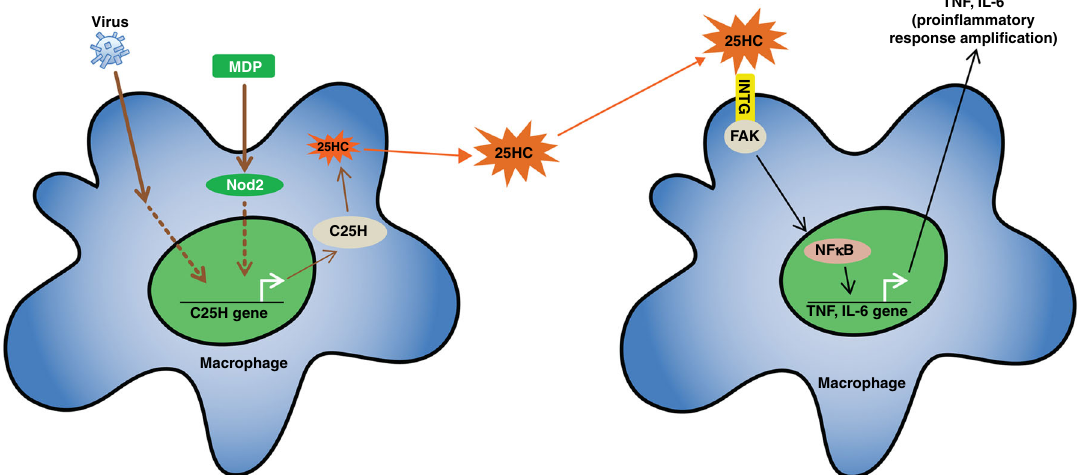
Fig. 8 A schematic model showing regulation of proin fl ammatory response by 25HC-integrin-FAK signaling network. Nod2 activation and virus (RSV and IAV) infection triggers expression of C25H, which results in production of 25HC. Extracellular 25HC activates integrin-FAK-NF κ B signaling. Thus, 25HC links PRR (Nod2) pathway with integrin-FAK-NF κ B signaling to confer optimal proin fl ammatory response following Nod2 activation and virus